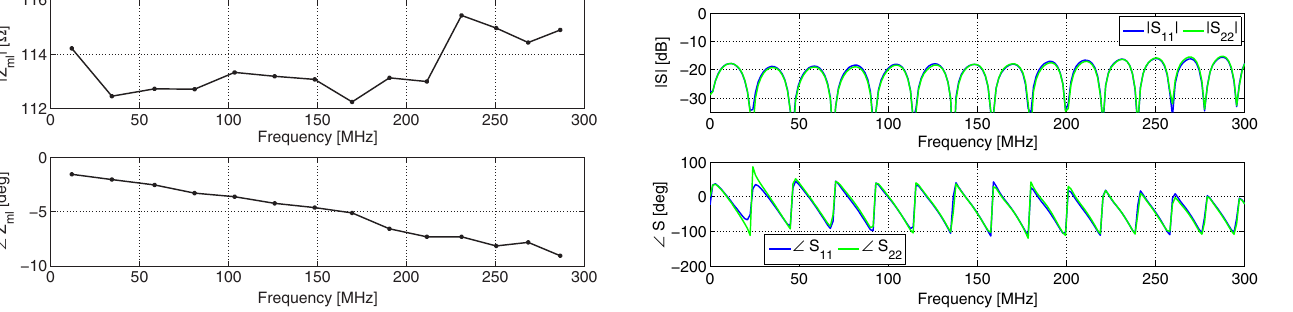
FIG. 10. Modulus and phase of Z ml for the frequencies where (cid:1) ml L ml ¼ (cid:2) ð 2 k þ 1 Þ = 2 .